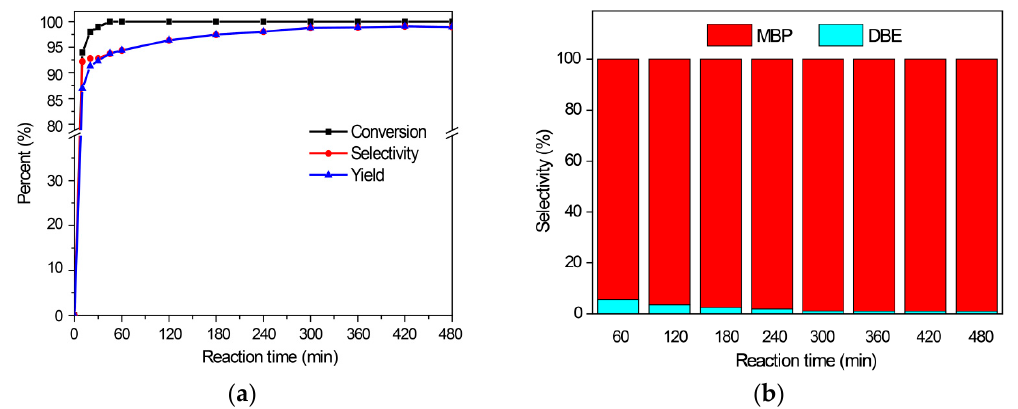
Figure 6. Benzylation reaction of toluene and benzyl alcohol at 373 K. ( a ) Conversion (based on benzyl alcohol), selectivity and yield (referred to diphenylmethane). ( b ) Product distribution of mono benzylation products (MBP, benzyl-2-methylbenzene in this case) and DBE.